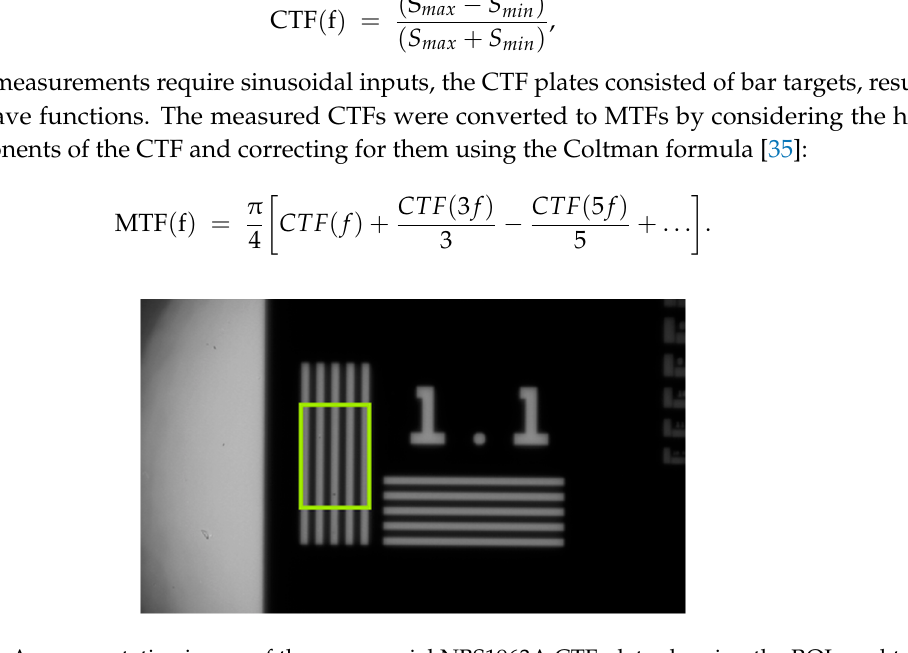
Figure 5. A representative thermal image of a lit domestic wood and coal burning stove. The imaging resolution is sufficient to resolve details of the scene. The MFOV determines the minimum uniform feature size for which a truly quantitative measure of the temperature can be made.